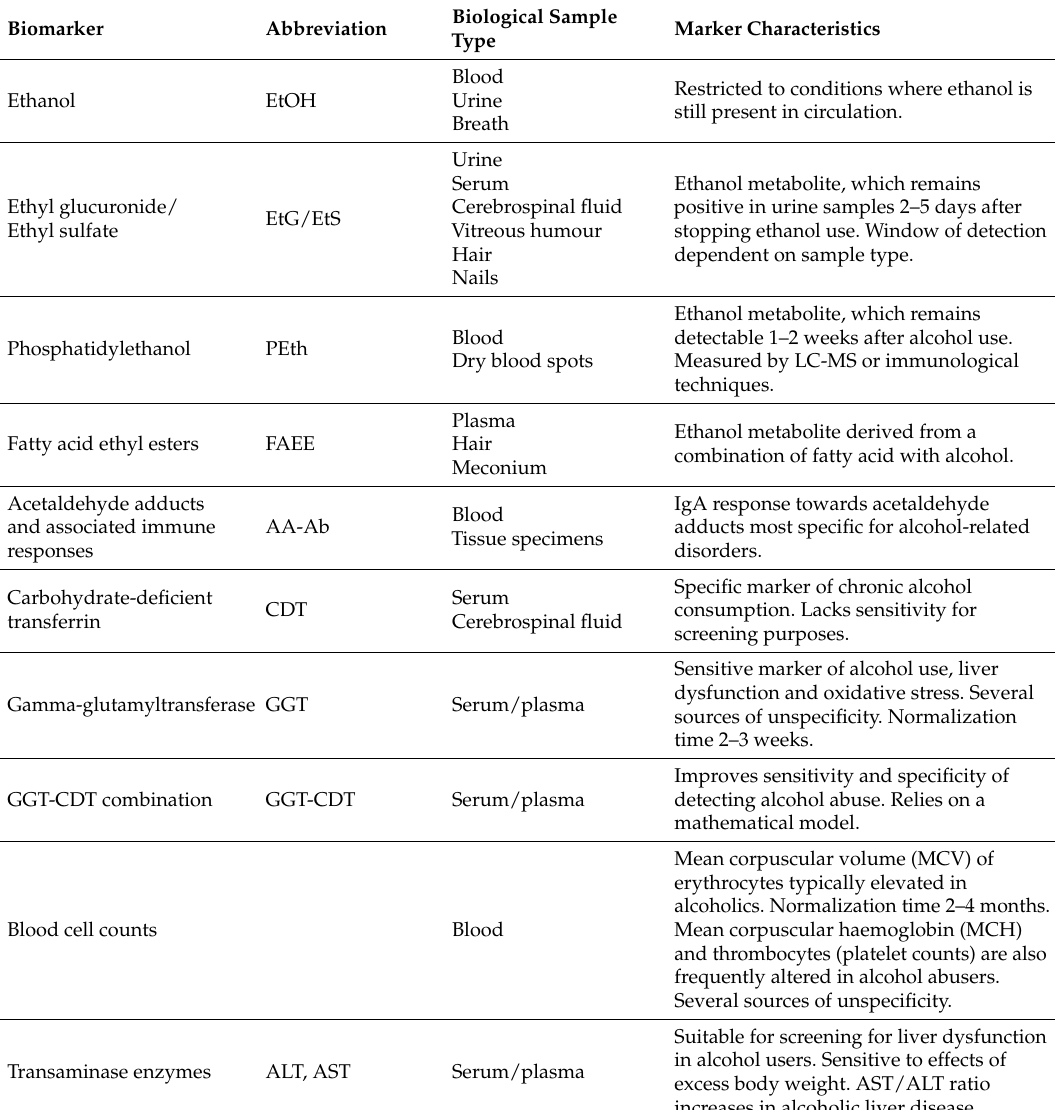
Table 1. Biomarkers of alcohol